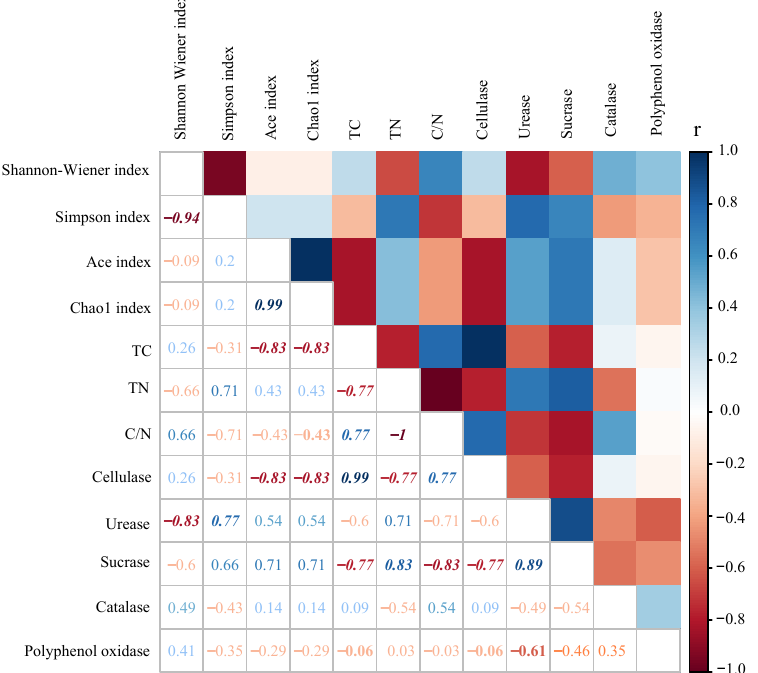
Figure 4. Spearman’s rank correlation analysis between diversity indices of protist communities and litter properties. Italics represent significant